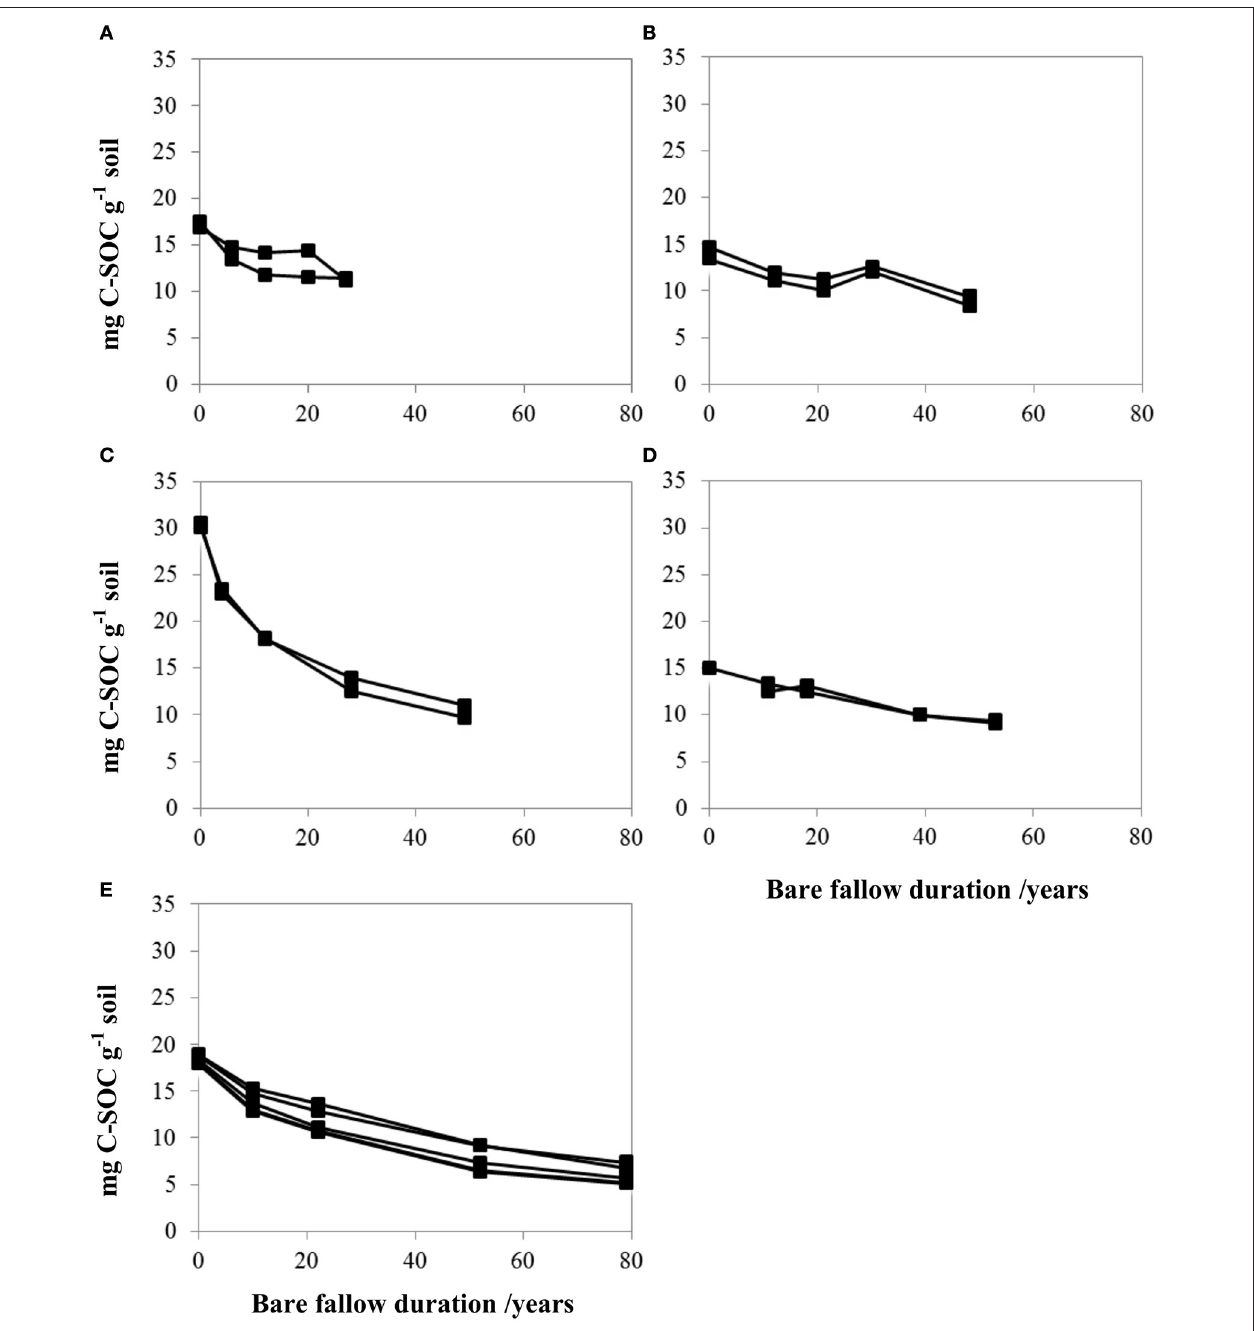
FIGURE 3 | SOC degradation dynamics with time at all sites (mg C.g − 1 soil) for all field replicates: Askov (A) , Grignon (B) , Rothamsted (C) , Ultuna (D) , and Versailles (E) . SOC represents the portion of total organic carbon which is not pyrogenic, SOC contents are calculated as the difference between TOC contents determined by elemental analysis and PyOC contents determined by BPCA